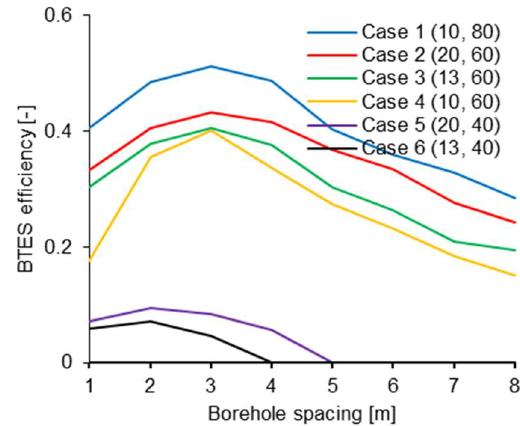
Figure 14. BTES efficiency as a function of borehole spacing. Values given in legend parentheses are the mass flow rate and temperature of the supply flow at heat injection respectively. The actual borehole spacing is 4 m.